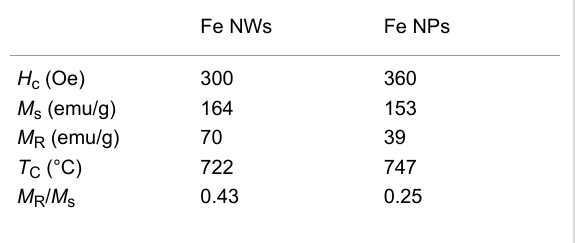
Table 3: Magnetic properties of iron nanowires and iron nanoparticles; H c – coercivity, M s – saturation magnetization, M R – remanent magne- tization, T C – Curie